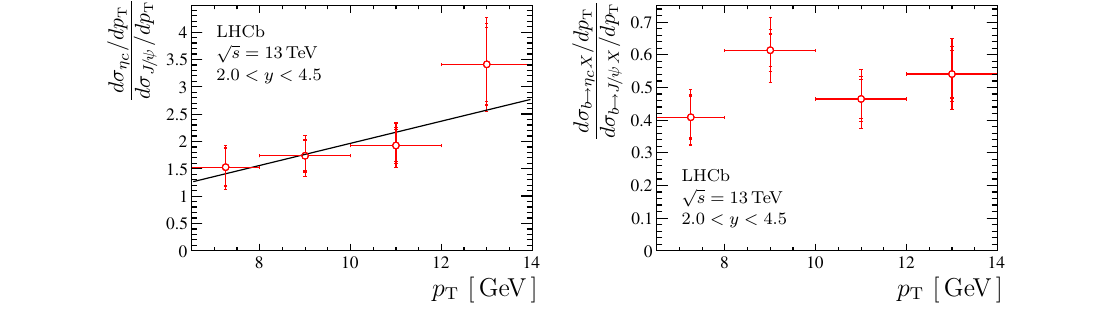
Fig. 3 Relative η c to J /ψ differential production cross-sections for (left) prompt production and (right) production in b -hadron inclusive decays. The uncertainties are statistical, systematic, and due to the